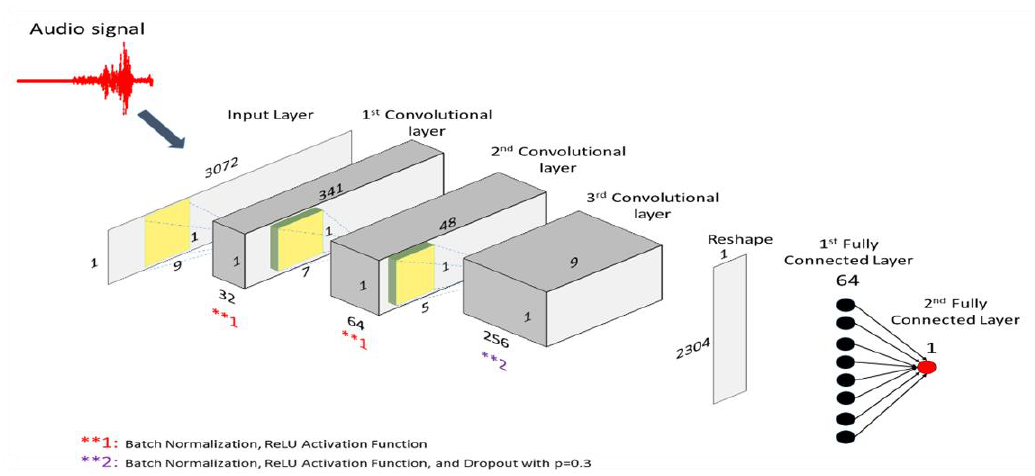
Figure 7. Architecture of the basic convolutional neural network (CNN) model.